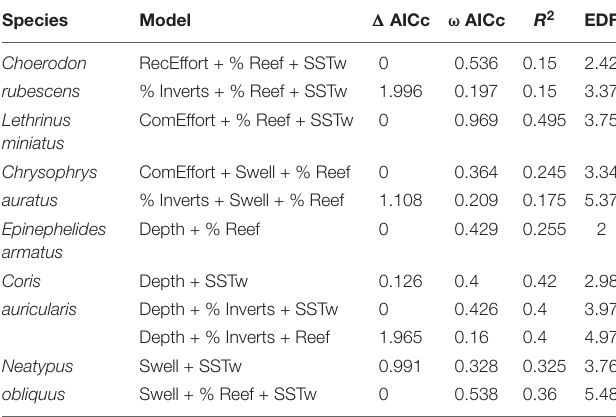
TABLE 2 | Top generalized additive models (GAMs) for predicting the abundance distribution of species of interest from full subset